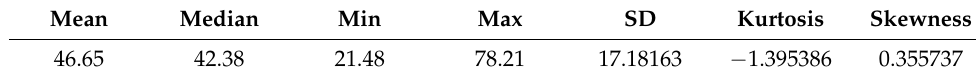
Table 9. Statistical characteristics of the “Average Bare Soil Temperature”.